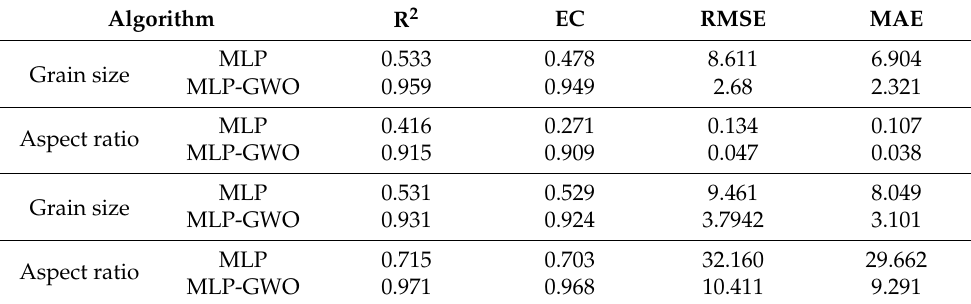
Figure 13. QQ plots for all predicted responses using MLP and MLP-GWO. Figure 13. Q Q plots for all predicted responses using MLP and MLP-GWO. Table 4. Evaluation of MLP and MLP-GWO results using statistical The accuracy of MLP and MLP-GWO models is evaluated using four statistical measures, namely R 2 , EC, RMSE, and MAE as tabulated in Table 4. MLP-GWO has the